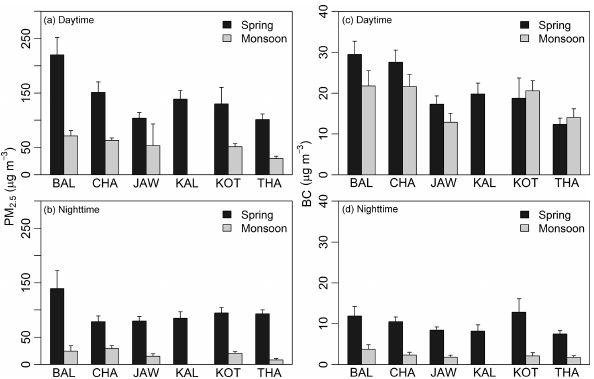
Figure 4. The mean concentrations of PM 2 . 5 (a, b) and BC (c, d) at nighttime (20:00–06:00 NST, Nepal standard time) and daytime (06:00–20:00 NST) over the sampling periods in the spring season and monsoon season of 2014 observed at six near-roadside locations in the Kathmandu Valley. Error bars are the standard deviation of the measurements.